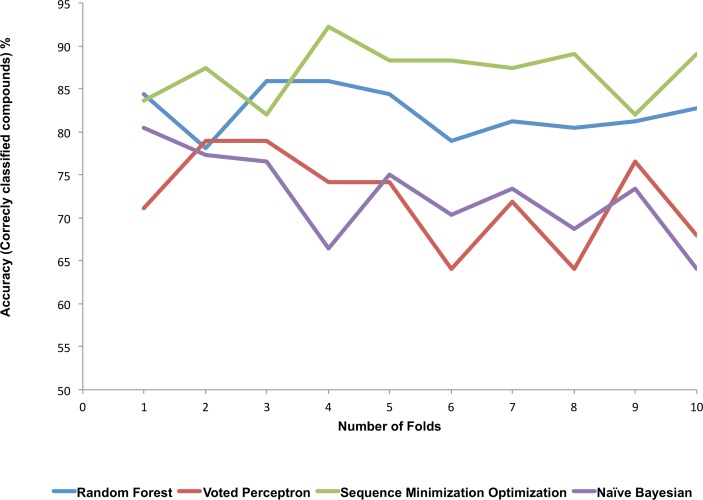
The graph shows values of the accuracy (percentage of correctly classified compounds) of the four classifier models over the 10 folds cross-validation.The sequence minimization optimization (SMO) and Random Forest (RF) classifier models showed greater predictive accuracy than the Naïve Bayesian (NB) and Voted Perceptron (VP) classifier models.